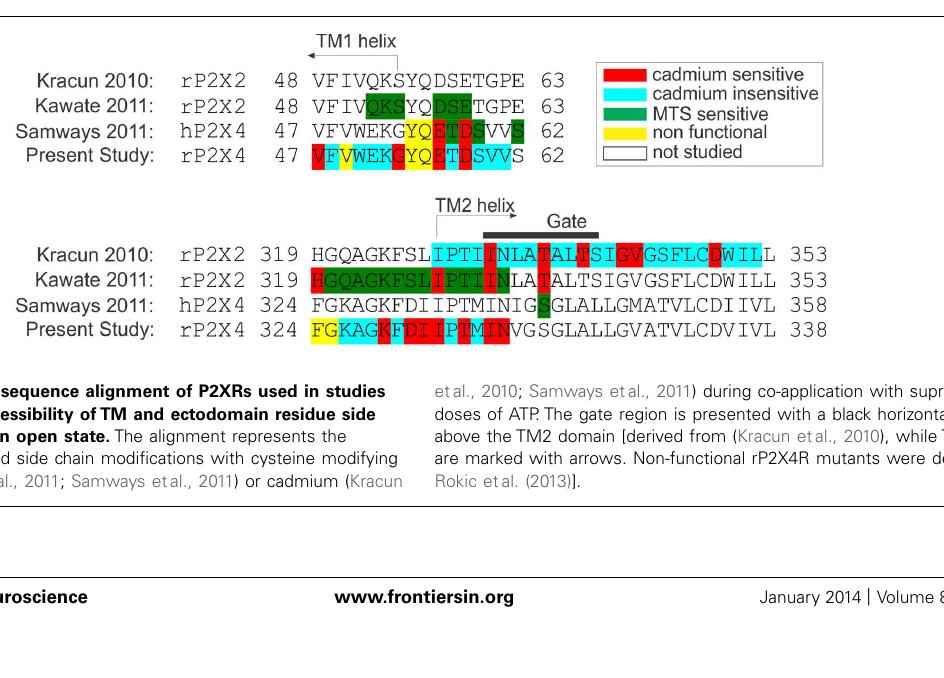
etal., 2010; Samways etal., 2011) during co-application with supramaximal doses of ATP. The gate region is presented with a black horizontal line above the TM2 domain [derived from (Kracun etal., 2010), while TM helices are marked with arrows. Non-functional rP2X4R mutants were described in Rokic etal.